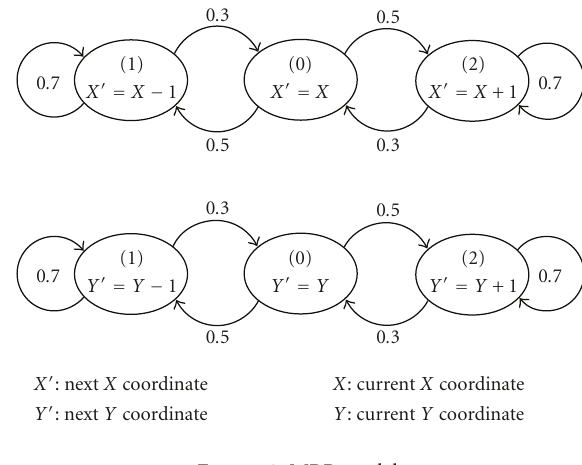
Figure 1: Course taken by one MN using the RWP model. Figure 2: MRP